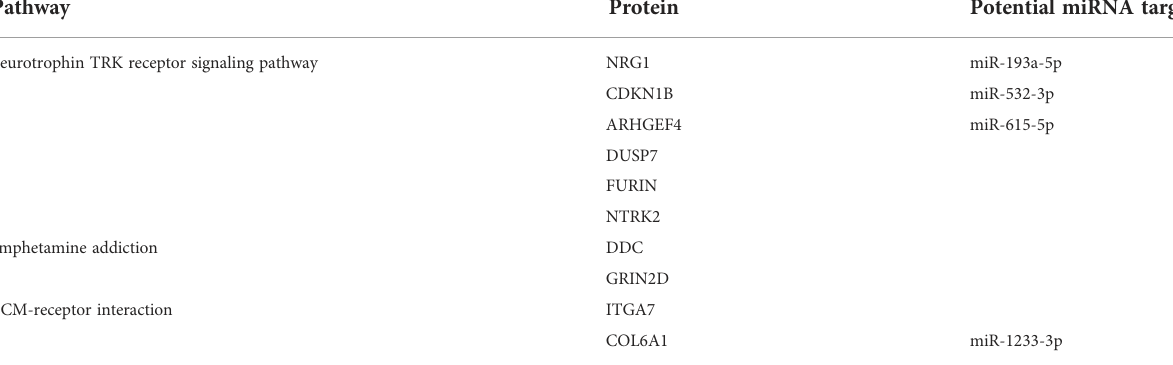
TABLE 1 Pathway and potential miRNA target of 10 signi fi cantly differentially expressed proteins.